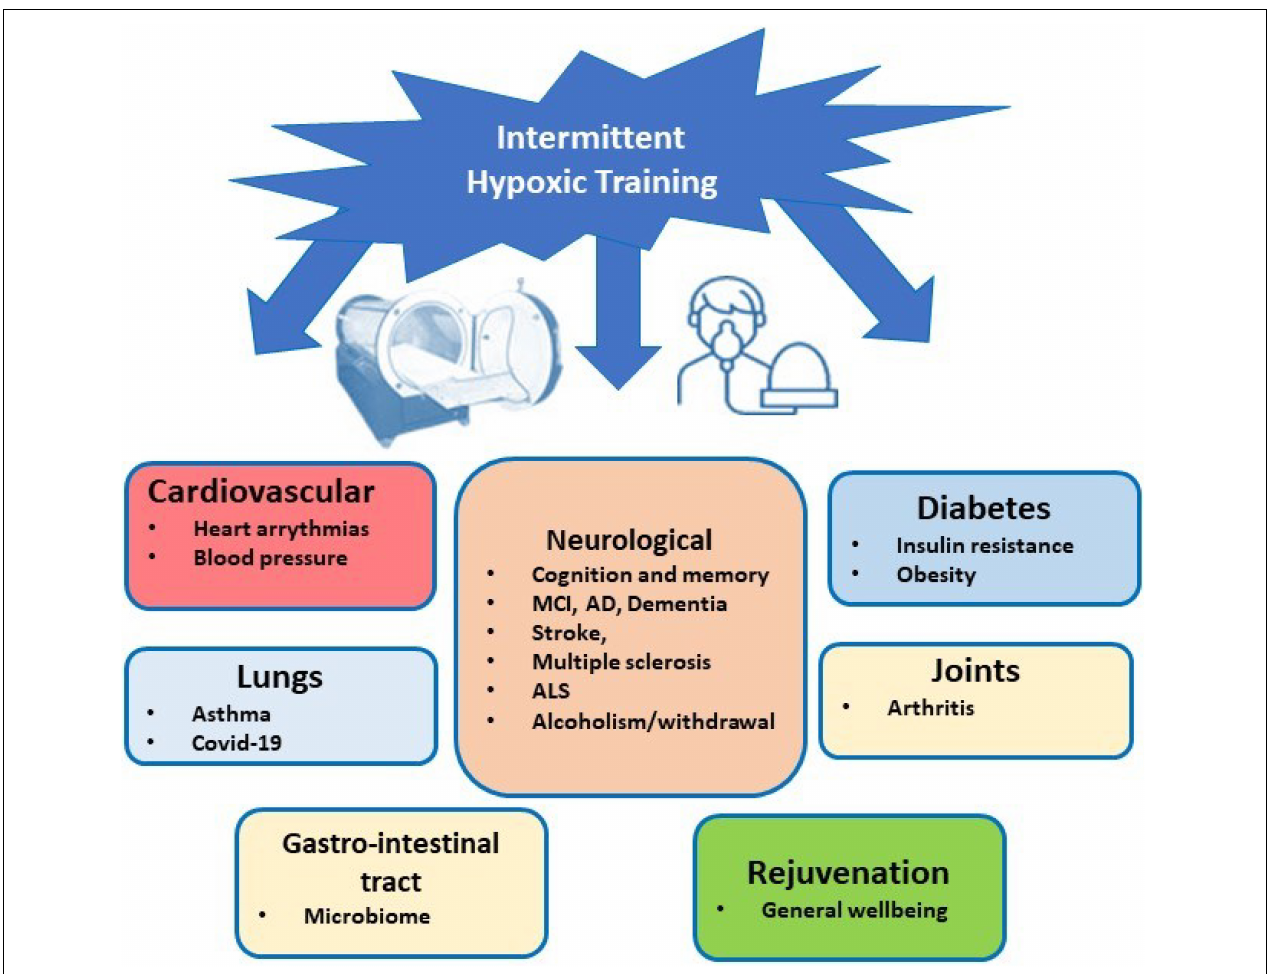
FIGURE 1 | Schematic presentation of potential therapeutic benefits of